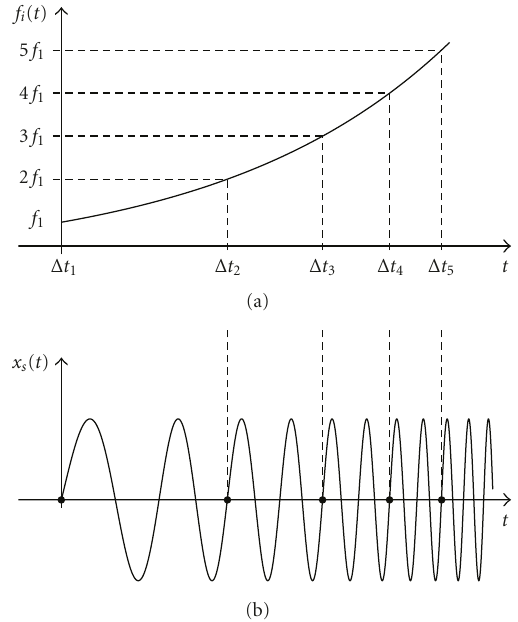
Figure 1: Swept-sine signal x s ( t ) in the time domain (b), with the time length chosen according to the instantaneous frequency f i ( t )